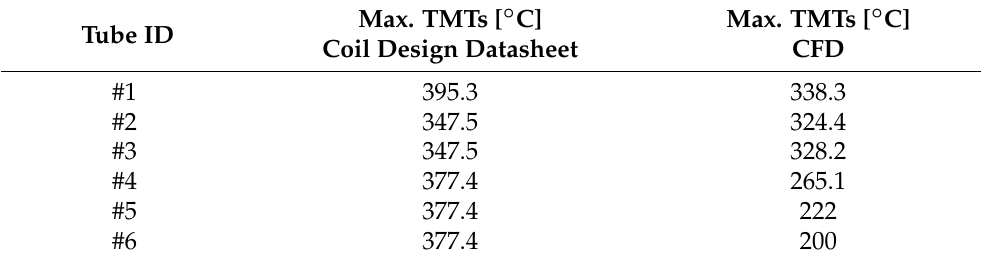
Table 16. Comparison between maximum TMTs per design and TMTs per CFD results.